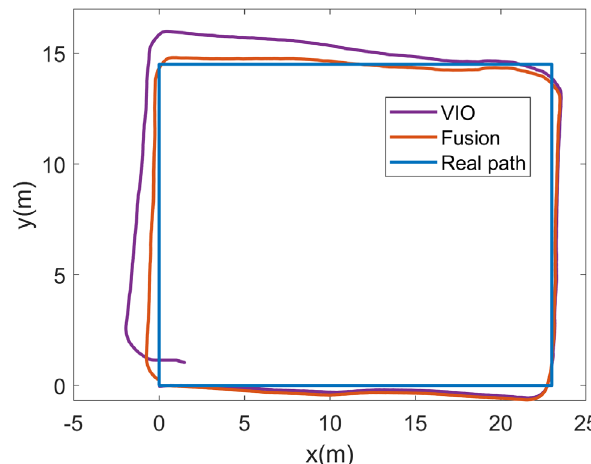
Figure 15. Moving trajectory of the covered